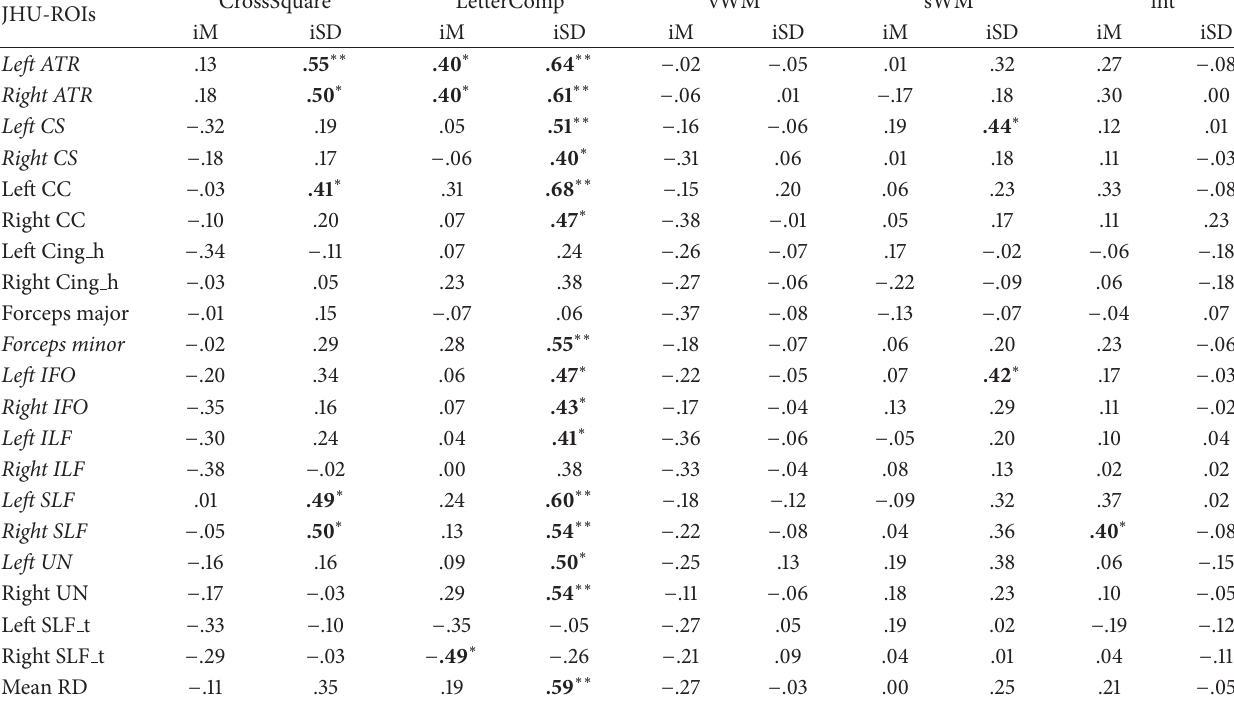
Table 5: Correlations between RD in the JHU-ROIs and cognitive